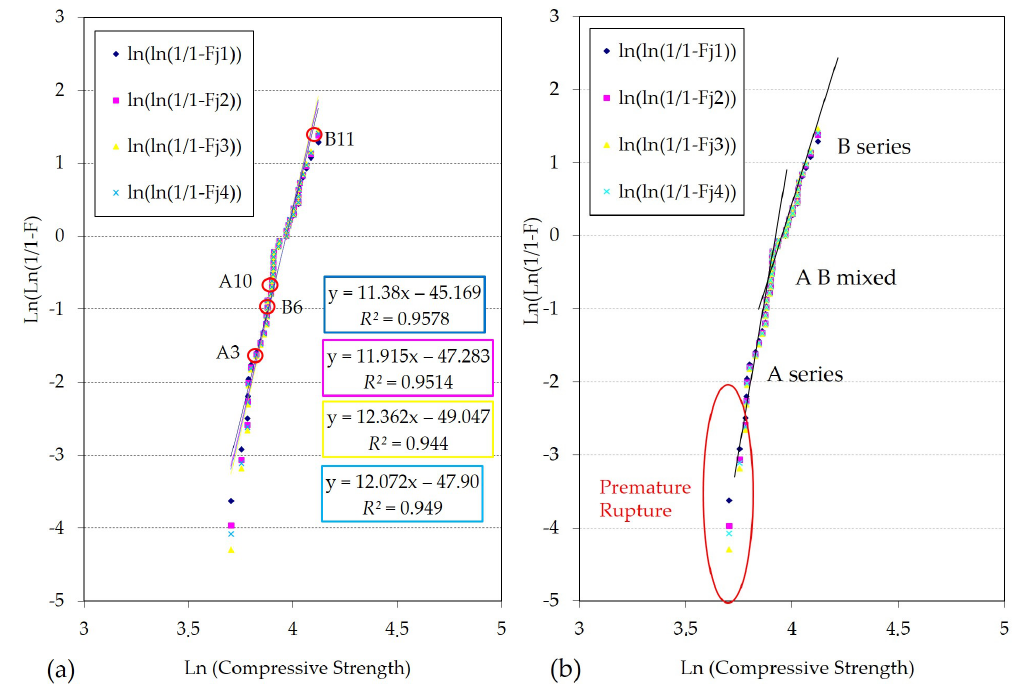
Figure 15. Weibull plot for all samples tested: ( a ) traceability of the selected specimens within the graph and ( b ) approximate discrimination of the series.